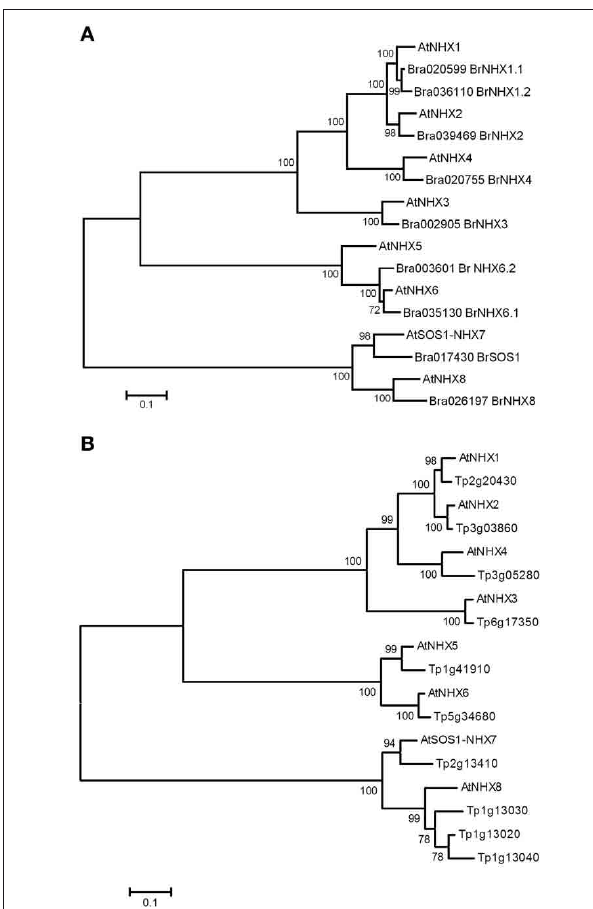
FIGURE 2 | Phylogenetic analysis of B. rapa and T. parvula NHX proteins. Amino acid sequences of NHX proteins from B. rapa (A) , T. parvula (B) and A. thaliana were aligned using Clustal W, and a Neighbor-joining tree generated. Numbers at nodes correspond to bootstrap support percentages following 1000 replications, and the scale is in amino acid changes per